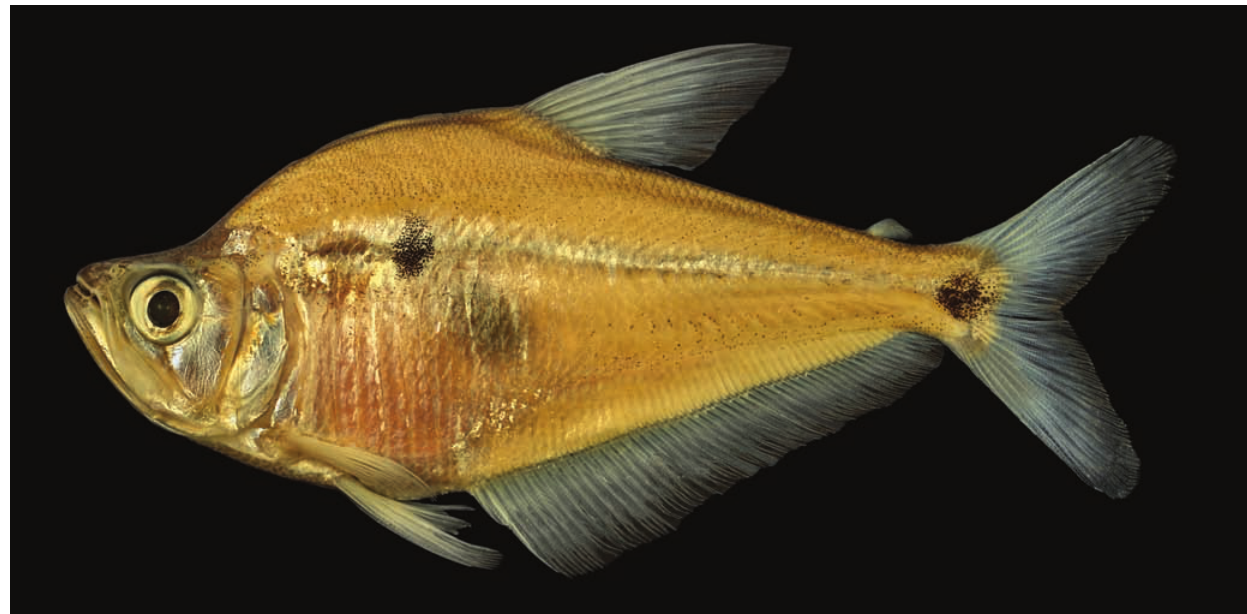
Fig. 14. Charax leticiae , MZUSP 89382, female, 98 mm SL, Brazil, Goiás, between Crixás and Nova Crixás, córrego da Taboca, tributary of rio